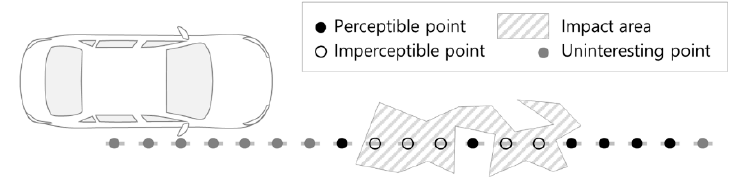
Figure 5. Perceptible and imperceptible points with impact area.